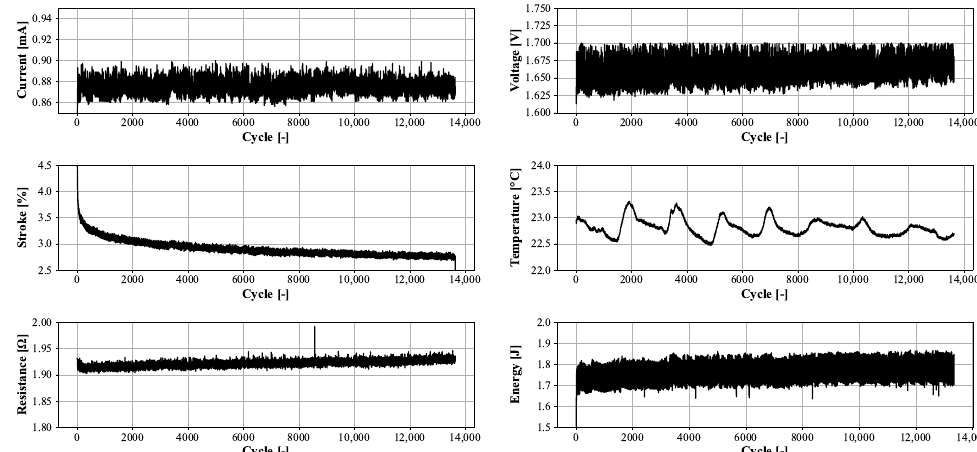
Figure 7. Full endurance test ot the test rig of test setup I showing the current [A] and voltage for activation [V], peak values of displacement [mm], ambient temperature [°C], energy [J] and resistance of the wire [ Ω ] over test cycles